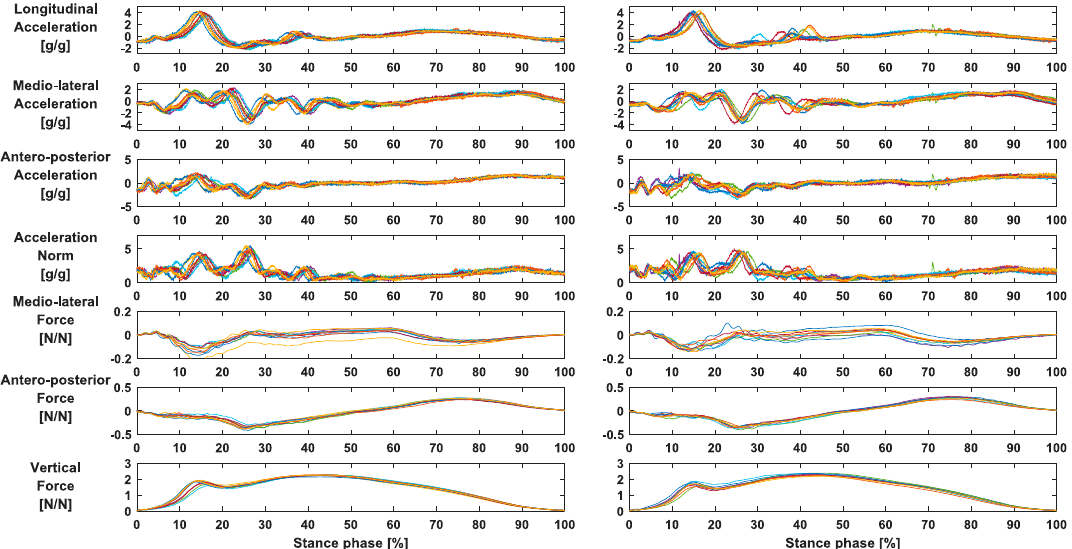
Figure 2. Normalized running signals for acceleration and force during stance for the study TEST. Results for the intra-test repeatability (ten trials of the participant over one session— left ) and for the inter-test repeatability (one trial of each session— right ).